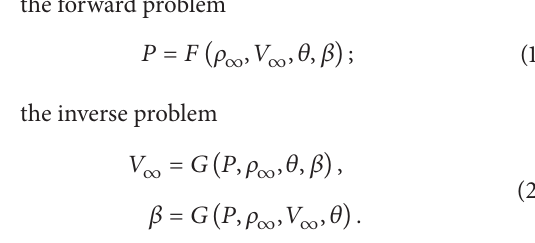
completely around the structure and can routinely experience separated and unsteady cross-flow. Finally, to compete with conventional air data systems, the FADS must be able to estimate wind speeds ( 𝑉 ∞ ) over a range of 40 to 120 fps, ± 3.4 fps (i.e., ± 2 knots), and wind directions ( 𝛽 ) ranging from 0 to 360 degrees, ± 2 degrees. For more details on assessment of conventional air data systems please refer to